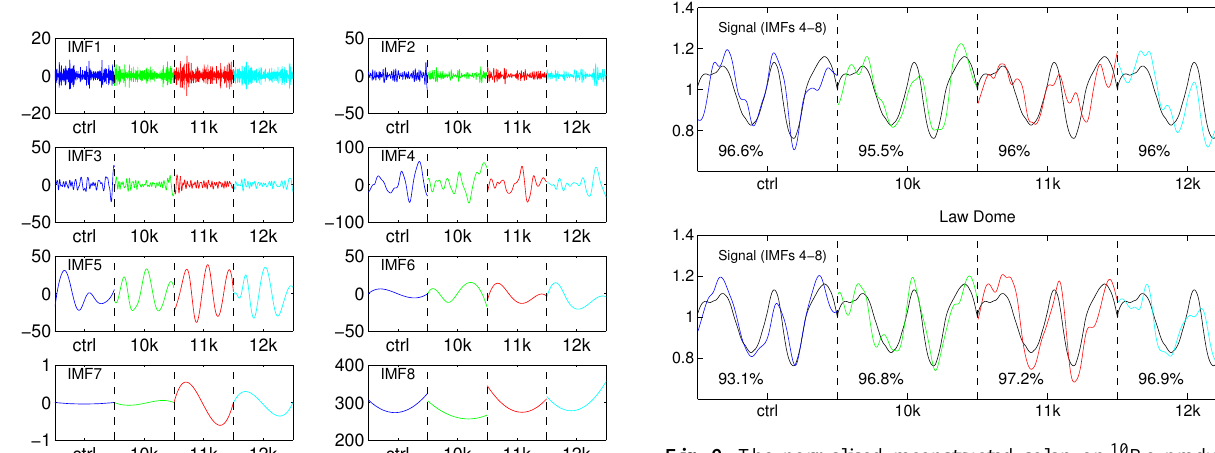
Fig. 9. The normalised reconstructed solar, or 10 Be production, ’signal’ (IMFs 4-8) from the 10 Be deposition with the high-frequency noise removed for the four simulations, compared with the normalised original production signal (black). The percentages show the variability explained by the ’signal’ components in each simulation.